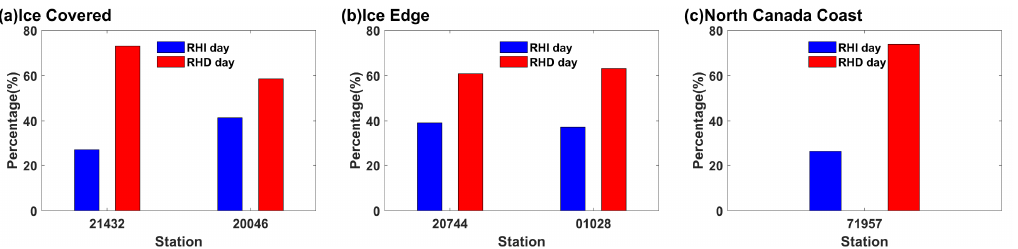
Figure 11. Percentages of relative humidity increase (RHI) days (blue column) and relative humidity decrease (RHD) days (red column) in the total cyclone days at ice-covered station 21432 and station 20046 ( a ), the ice edge station 20744 and station 01028 ( b ), and the North Canada coast station 71957 ( c ).